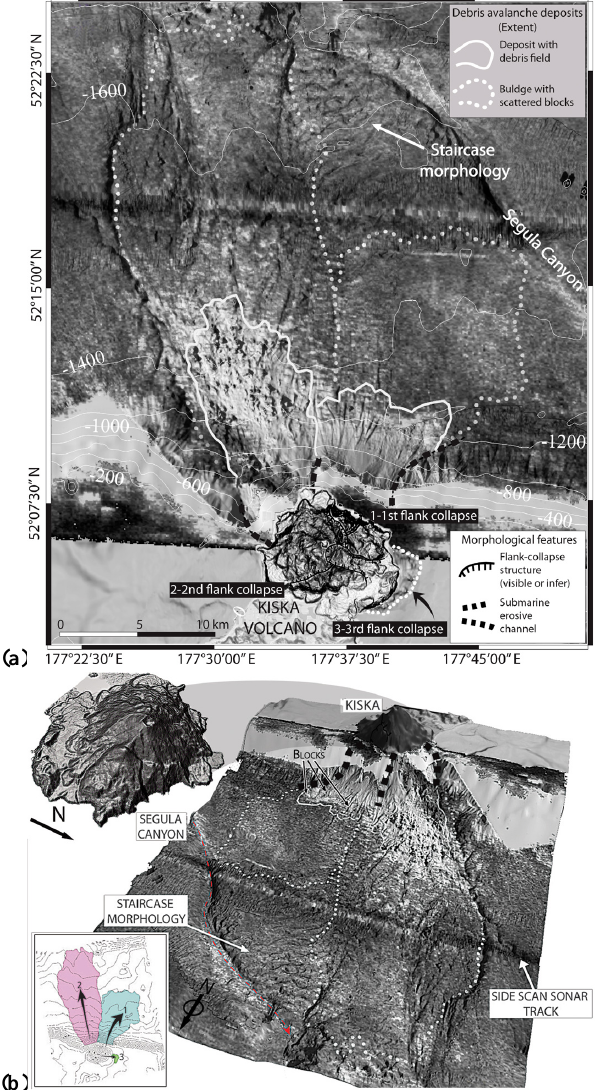
Fig. 3. (a) plan view: topography, bathymetry and Gloria side-scan data of Kiska volcano and its northern submarine slopes. (b) 3-D view: is reported also a detailed view of the subaerial volcanic cone morphology exposing fault planes and collapse craters. For side scan data the black is low backscatter and white is high backscatter. Contour interval is